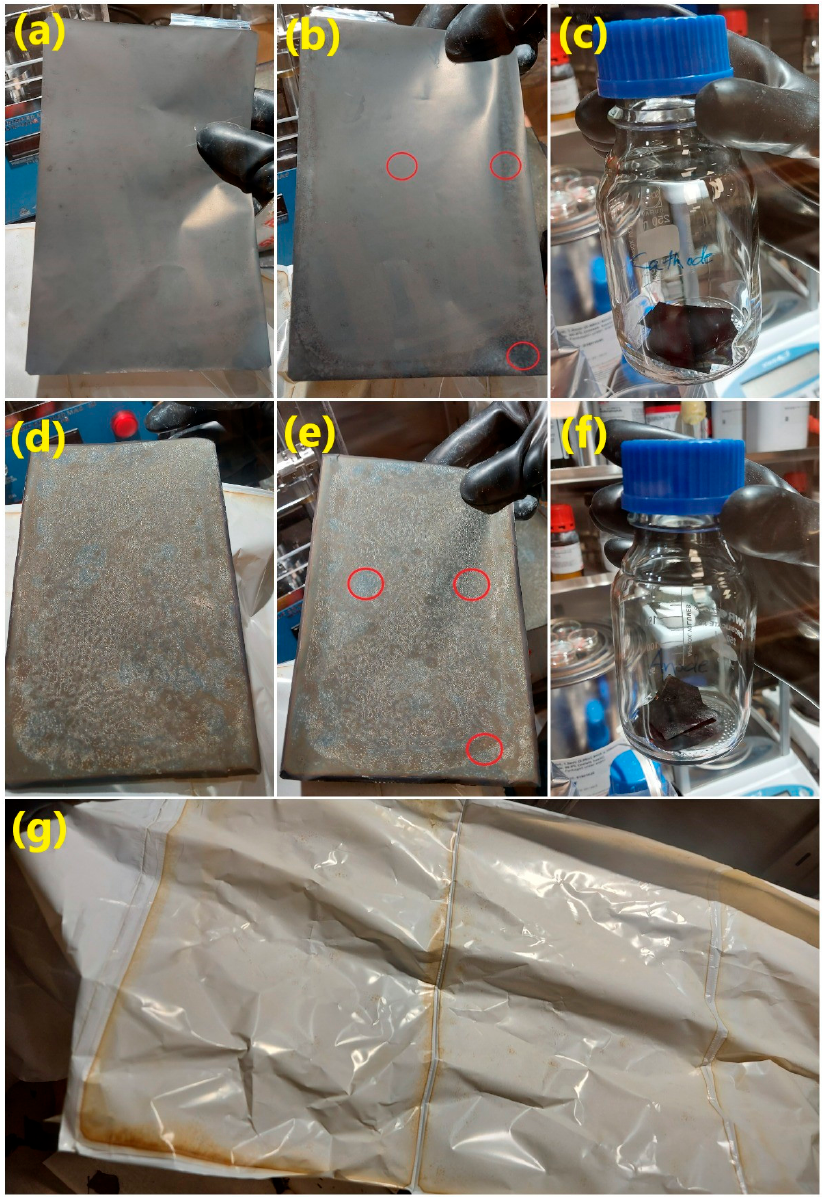
Figure 5. Disassembled cell components and sampling: ( a ) cathode sheet, ( b ) selected cathode sampling areas, ( c ) collected cathode samples, ( d ) anode sheet, ( e ) selected anode sampling areas, ( f ) collected anode samples, and ( g ) dried separator.